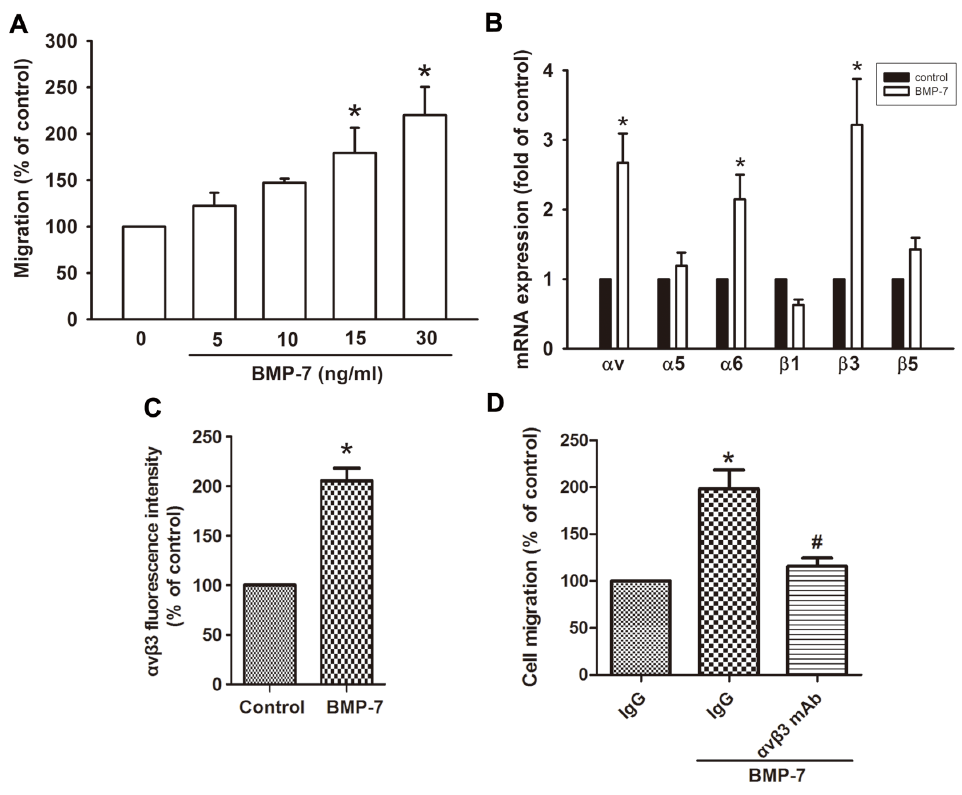
Figure 1. BMP-7 enhanced cell migration through up-regulation of integrin a v b 3 expression. (A) JJ012 cells were incubated with BMP-7 (5–30 ng/ml) for 24 h, and in vitro migration was measured with the Transwell after 24 h (n=6). (B) JJ012 cells were incubated with BMP-7 (30 ng/ml) for 24 h, and mRNA expression of a v, a 5, a 6, b 1, b 3, and b 5 integrin were examined by q-PCR (n=6). (C) Cells were incubated with or without BMP-7 for 24 h and the protein expression levels of integrin a v b 3 were examined by flow cytometry analysis (n=5). (D) Cells were pretreated with a v b 3 monoclonal antibody (10 m g/ml) for 30 min followed by stimulation with BMP-7. The in vitro migration activity measured after 24 h (n=5). Results are expressed as the mean 6 SEM. * p , 0.05, compared to basal expression